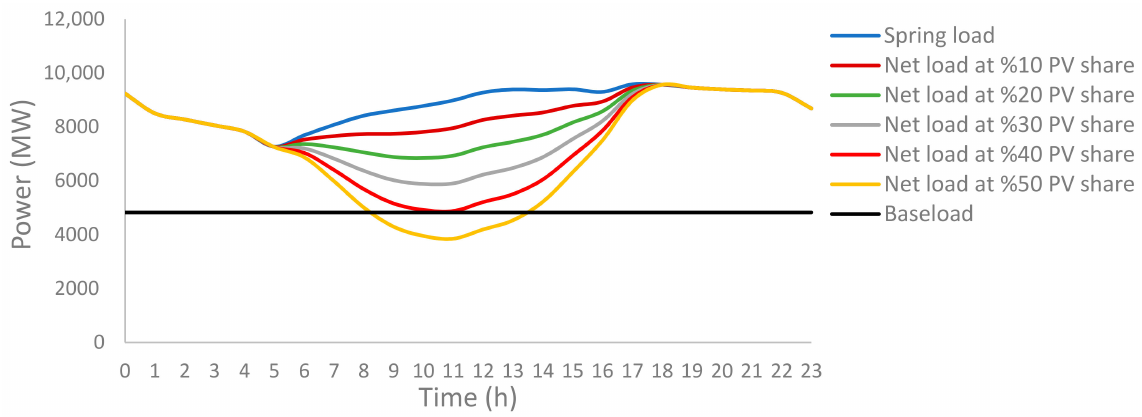
Figure 11. The impact of the PV system penetration level on the grid in terms of net load during the spring season.